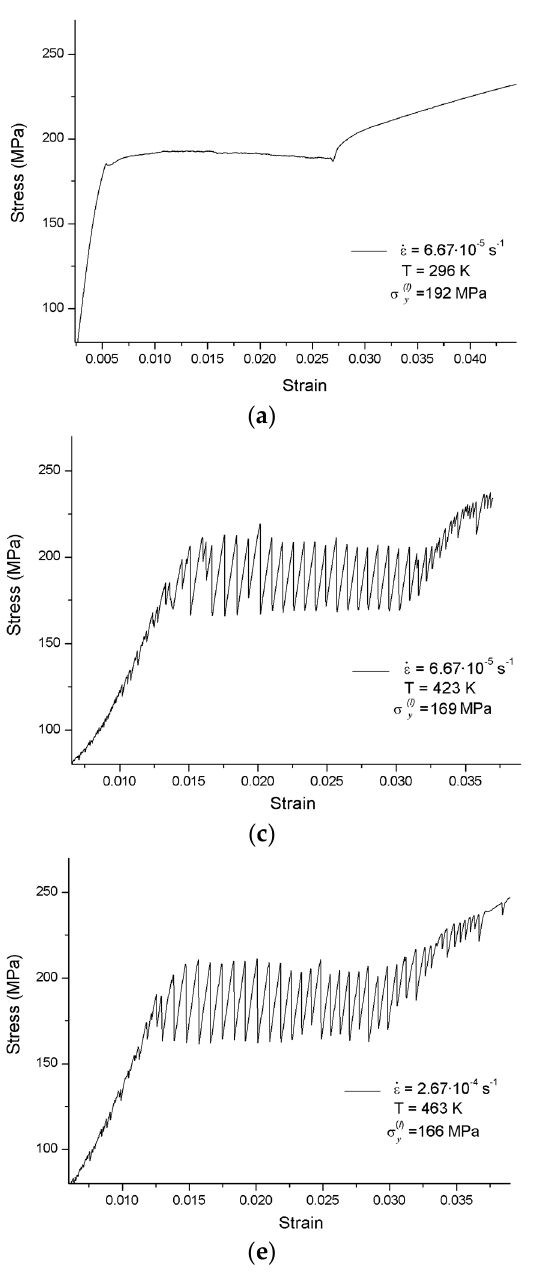
. ε = 6.67 · 10 − 5 s − 1 ( a ); T = 393 K, . ε = 2.67 · 10 − 4 s − 1 ( d ); T = 463 K,